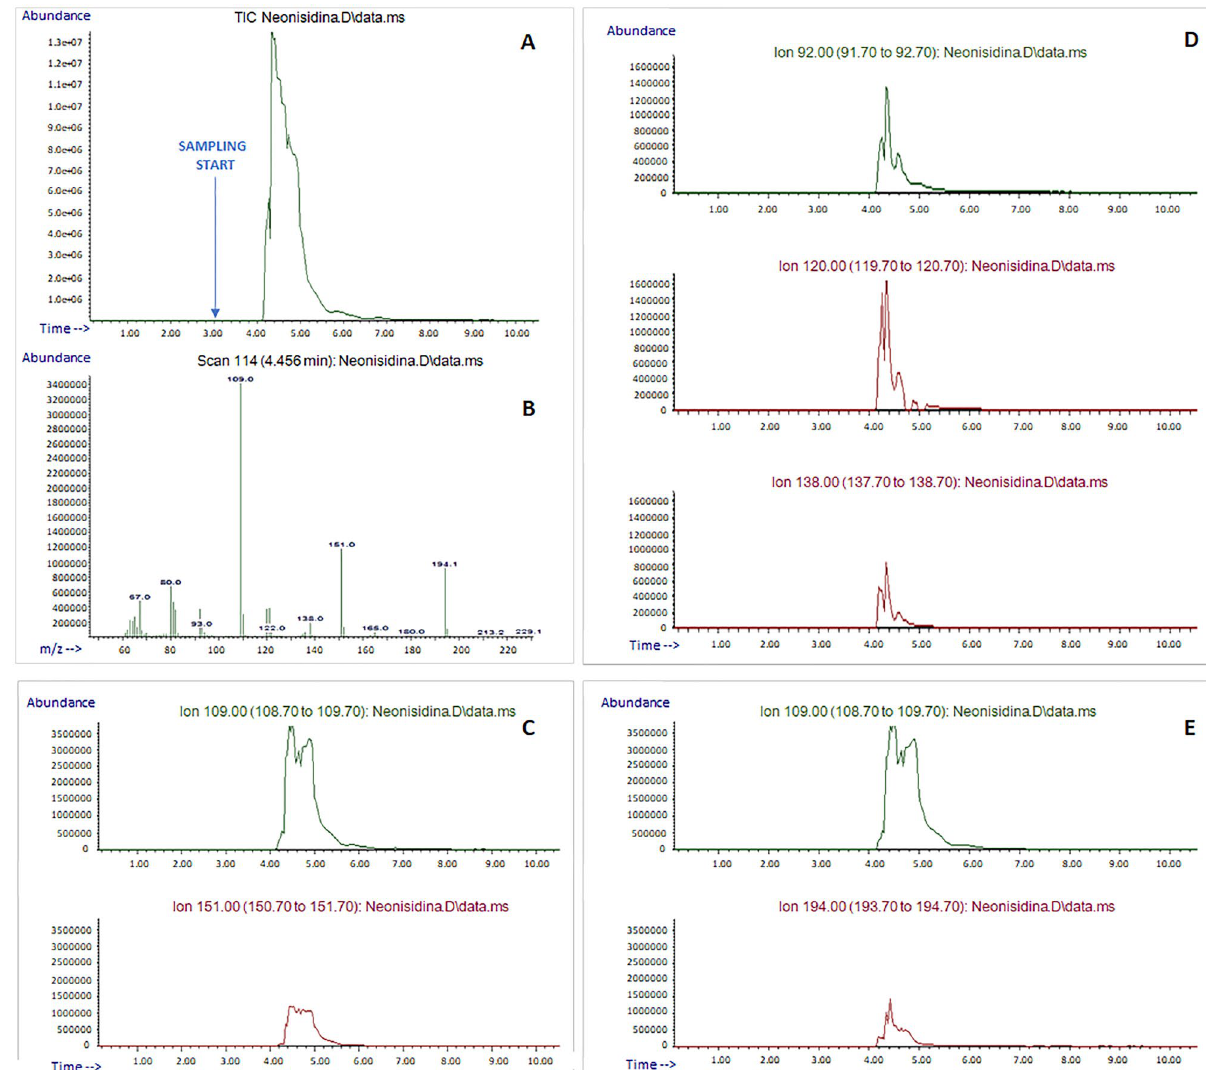
Figure 4. ( A ) Analysis of a NeoNisidina tablet: TIC; ( B ) EI experimental full spectrum; ( C ) acetaminophen selected ions: SIM; ( D ) acetylsalicylic acid selected ions: SIM; ( E ) caffeine selected ions: SIM. The arrow indicates the sampling